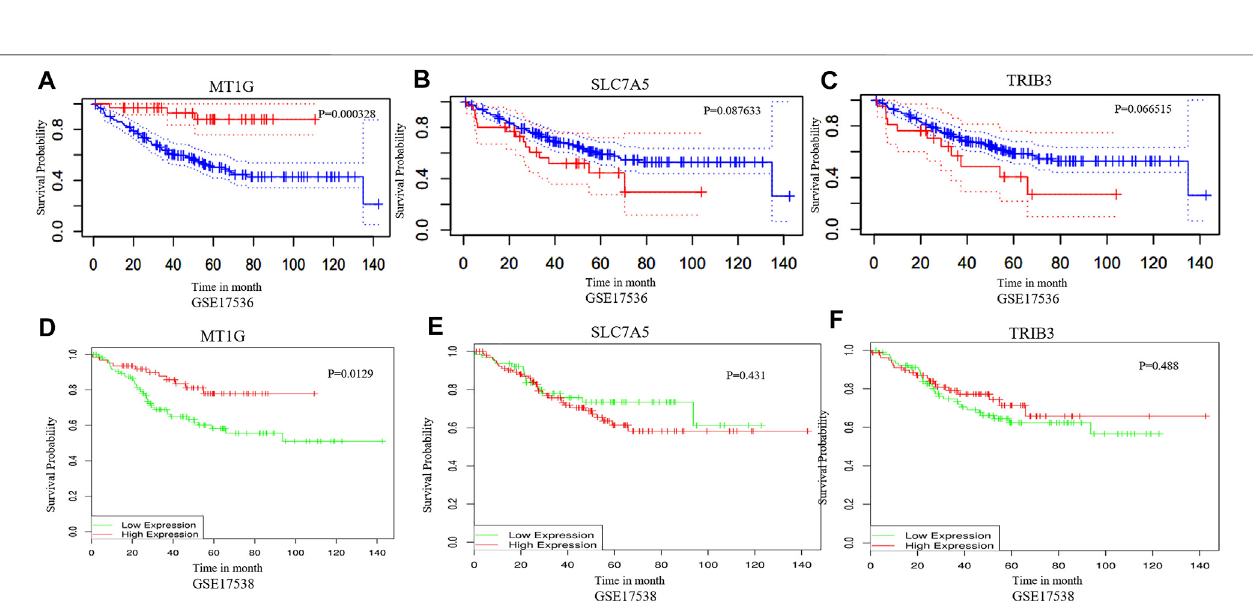
Frontiers in Cell and Developmental Biology |